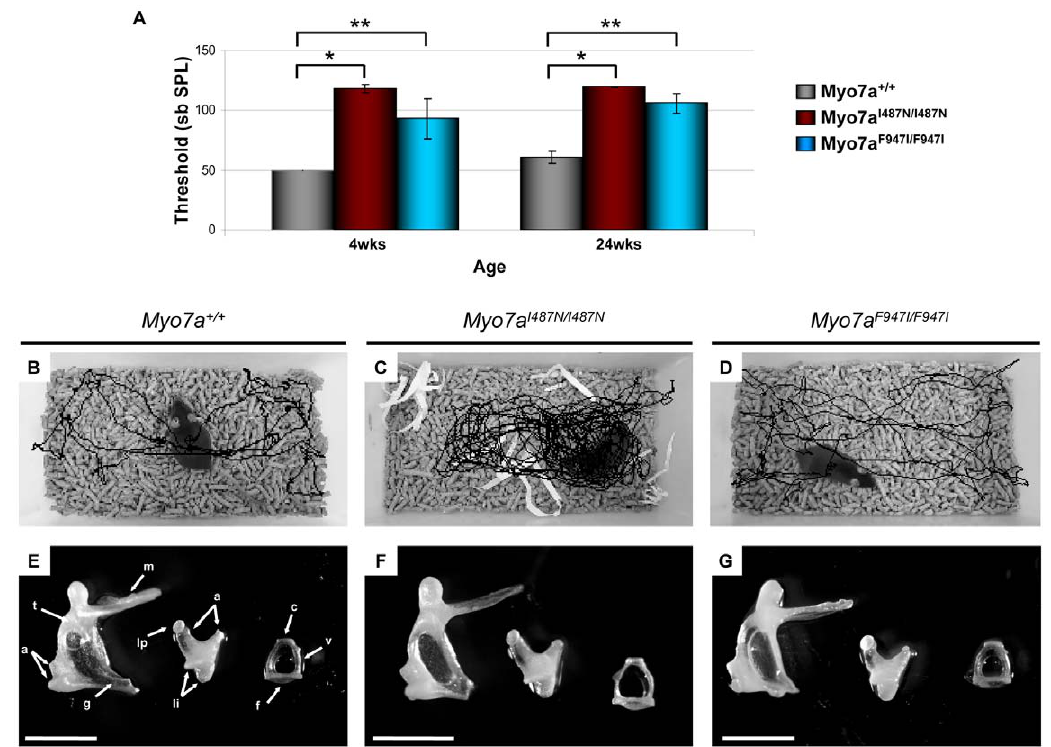
Figure 1. Phenotypic observations of Myo7a mutant strains. ( A ) Hearing profile of Myo7a + / + , Myo7a I487N/I487N ewaso and Myo7a F947I/F947I dumbo strains at 4 weeks (*p=2.2 6 10 2 25 , **p=4.5 6 10 2 10 ) and 24 weeks (*p=3.7 6 10 2 29 , **p=7.2 6 10 2 20 ). ( B–G ) Video surveillance and middle ear morphology in Myo7a strains. Observations highlighted an increased number of turns in Myo7a I487N/I487N ewaso mice ( C ), when compared to wild- type ( B ). No such behaviour was seen in Myo7a F947I/F947I dumbo mutants ( D ). Middle ear bones appear largely normal in Myo7a I487N/I487N ewaso ( F ) and Myo7a F947I/F947I dumbo ( G ) mutants, comparable to normal morphology of the malleus, incus and stapes ( E ). M; manubrium of malleus, A; articulation surfaces of malleus and incus joint, T; tubercle, G; gonial angle, LI; attachment points of suspensory ligaments of incus, LP; lenticular process, C; capitulum of stapes, V; arched ventral crus, F; footplate. Scale bar; 1 mm (E–G).